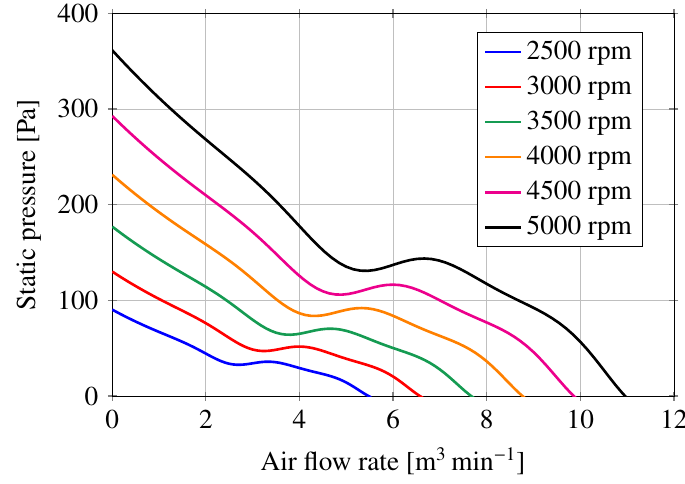
Figure 2. ∆ p - Q characteristics of the considered direct current (DC) fan for various